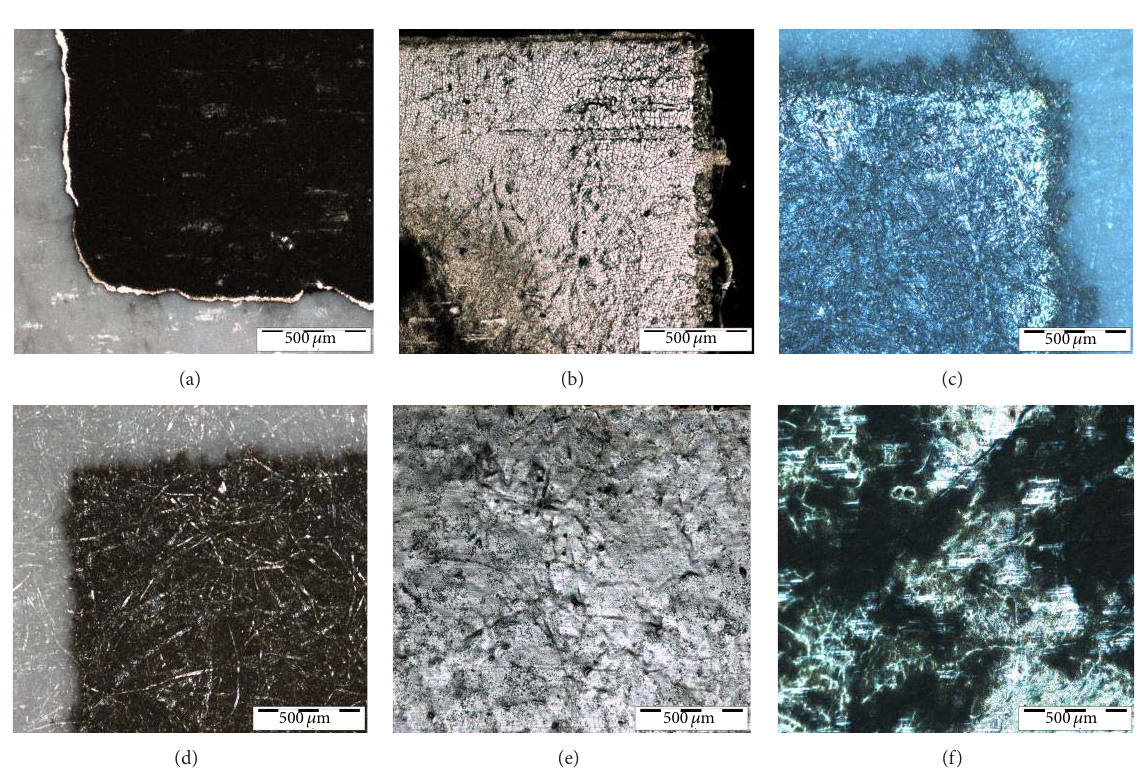
Figure 4: Microscopic images of the inkjet-printed layers: (a) surface of a one-layer line on Cardboard A, (b) surface of an eight-layer line on Cardboard A, (c) surface of a four-layer line on Cardboard B, (d) surface of a four-layer line on Paper A, (e) surface of a one-layer line on Paper B, and (f) surface of a two-layer line on Paper